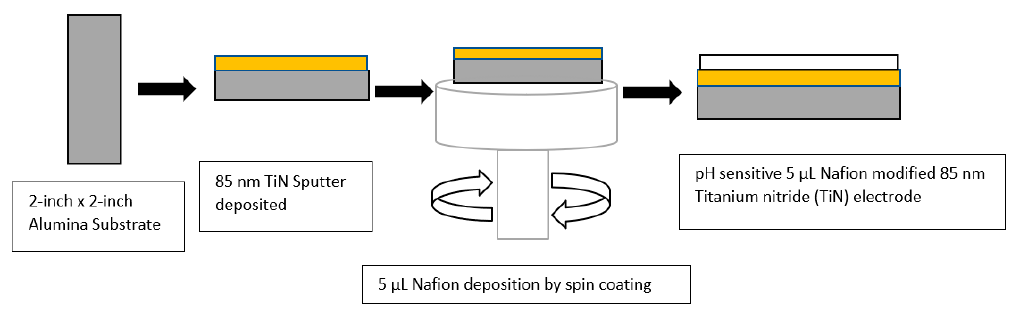
Figure 1. Schematic representation of 85 nm TiN electrode modified with Nafion.